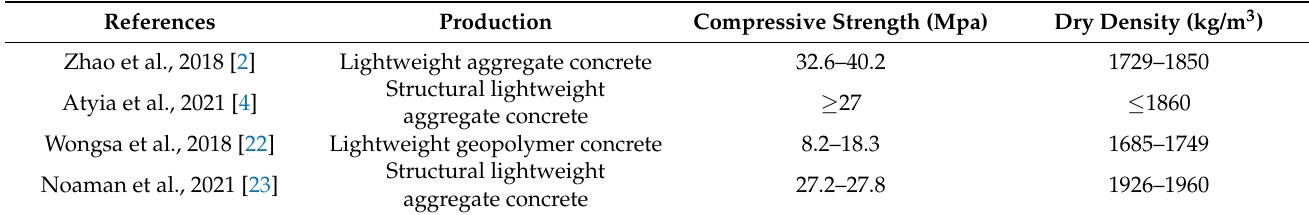
Table 1. Summary of research that examined the production of lightweight concrete with